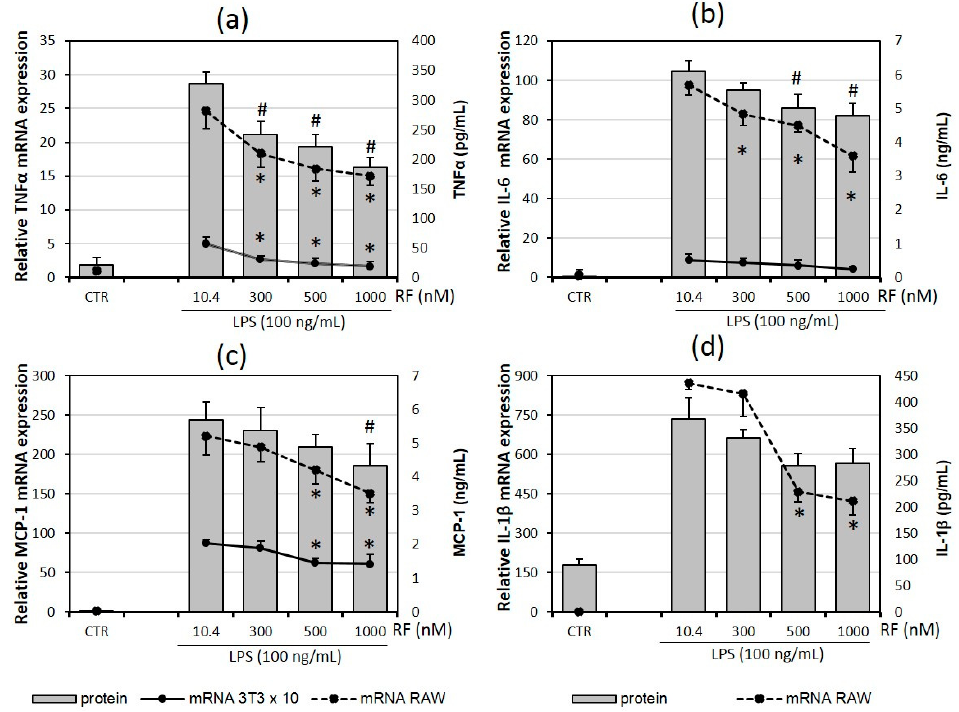
Figure 1. Effects of various riboflavin concentrations (10.4; 300; 500; 1000 nM) on LPS-induced: tumor